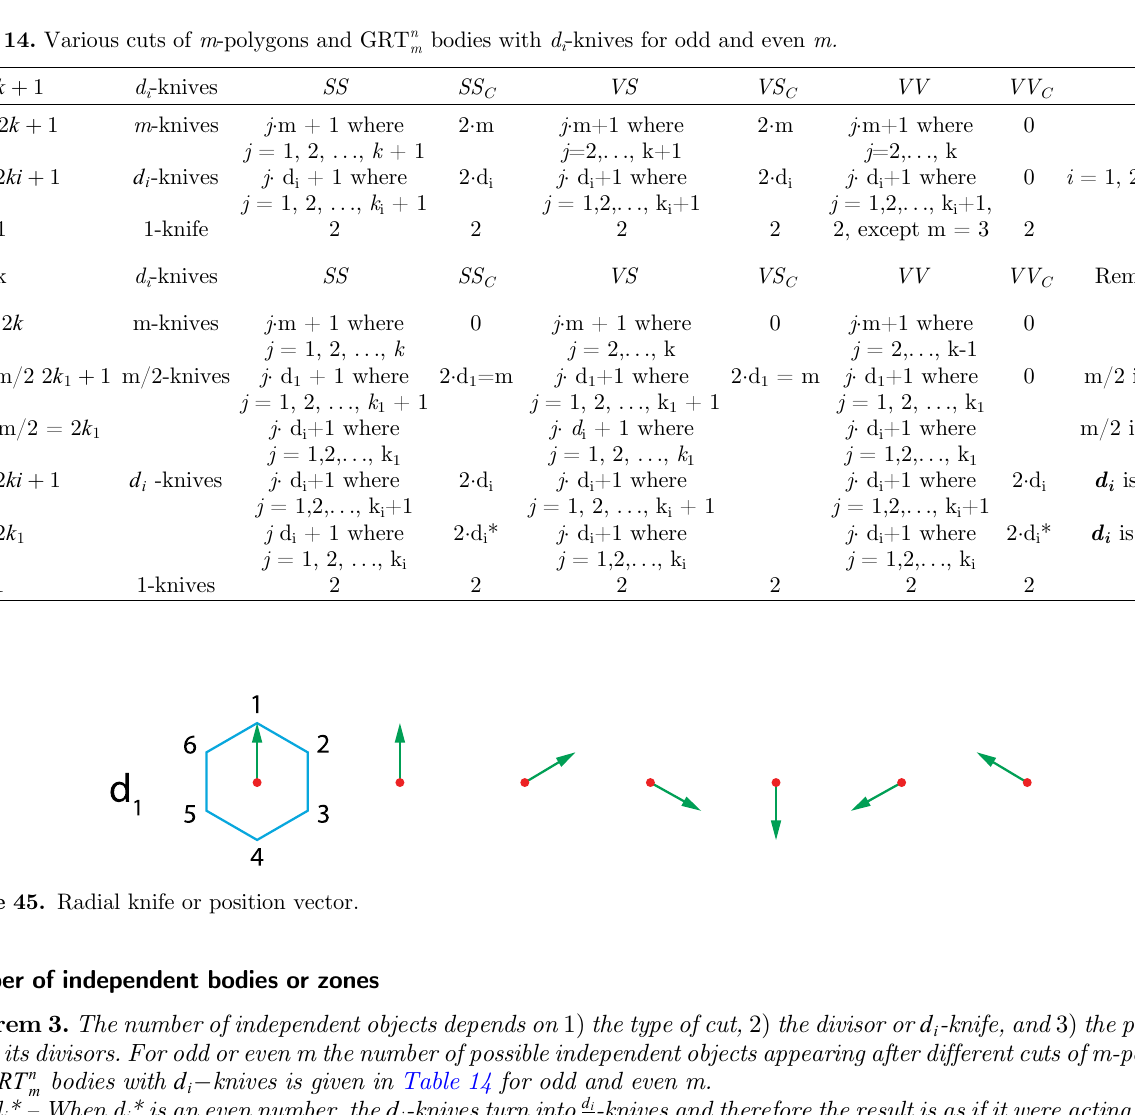
Table 14. Various cuts of m -polygons and GRT n